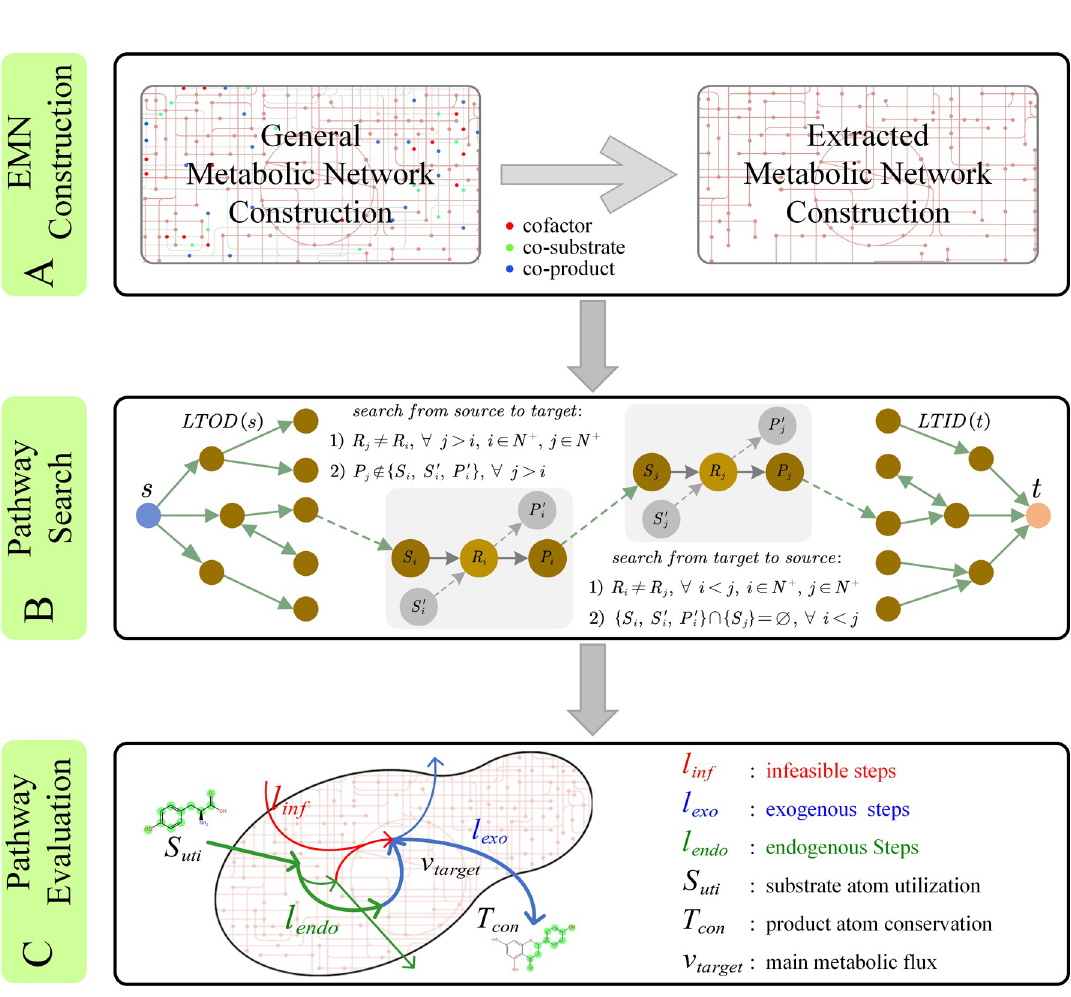
Fig 1. The workflow of PyMiner. (A) The construction of extracted metabolic network (EMN). The uniform similarity of substrate- product pairs was employed to construct EMN. (B) Metabolic pathway search. A conditional search strategy (CSS) established in this work was applied to cut search time. The green dashed arrow means multi-step reactions and the gray dashed arrow indicates implicit access of compound nodes (substrates or products). (C) Metabolic pathway evaluation. An exquisite set of evaluation indexes were adopted to evaluate and rank all the extracted metabolic pathways. See ‘Materials and methods’ section for more